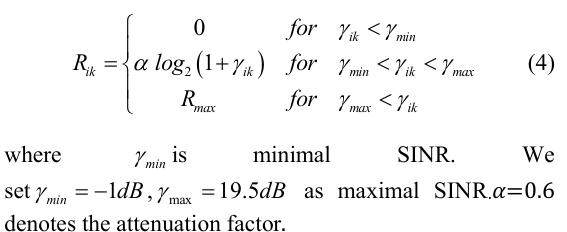
Fig. 1. System model of femtocell